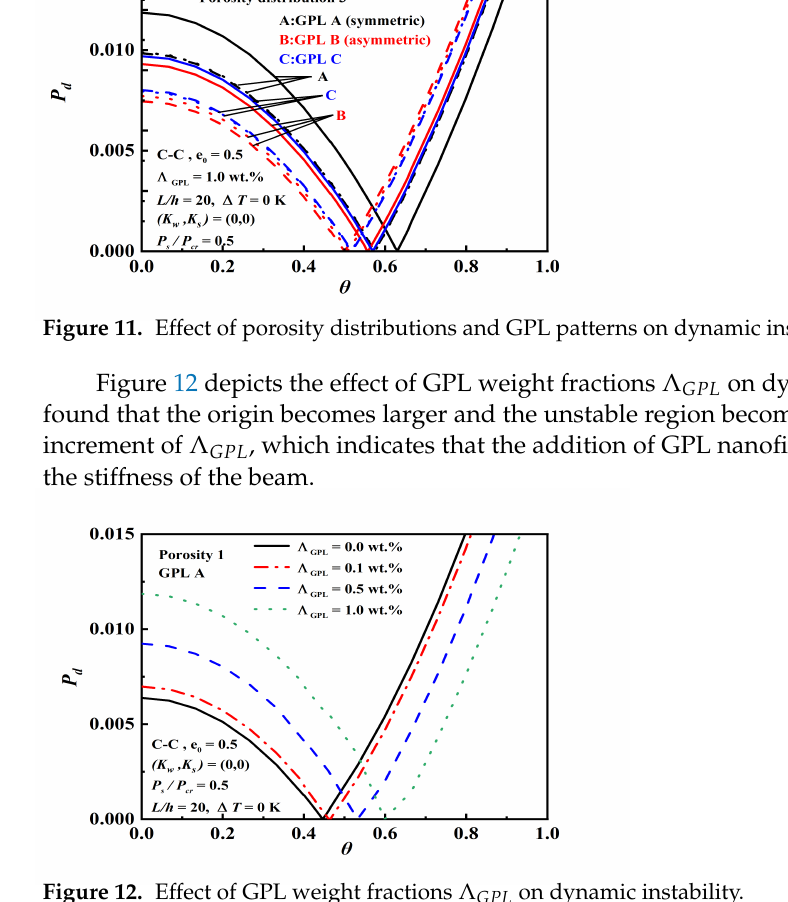
Figure 12. Effect of GPL weight fractions Λ GPL on dynamic